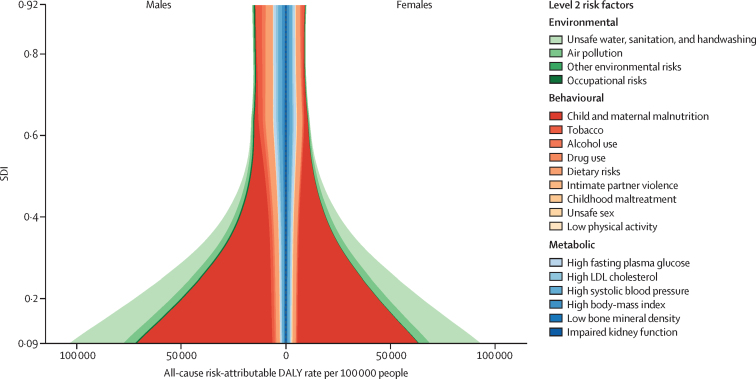
Expected relationship between all-age, all-cause risk-attributable DALY rates and SDI for each GBD Level 2 risk, 1990–2017Stacked curves show males (left) and females (right) after adjusting for mediation, scaling to account for overlapping risks, and aggregating so that total expected DALY rates reflect the true all-cause total expected DALY rates attributable to all risk factors. The y-axis shows lowest SDI (0·09) to highest SDI (0·92) for all GBD countries and territories, 1990–2017. Coloured regions are the proportion of the total attributable DALY rate corresponding to that risk factor. DALYs=disability-adjusted life-years. GBD=Global Burden of Diseases, Injuries, and Risk Factors Study. LDL=low-density lipoprotein. SDI=Socio-demographic Index.